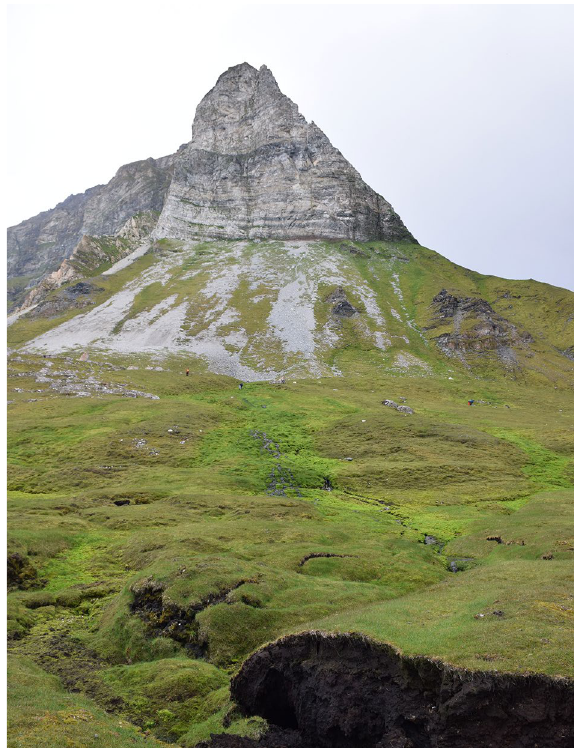
Figure 5. The general view of the Alkhornet study site. Thick peat layer can be seen in the wall of erosion gully on the front and bird cliff providing nutrients for the site in the back of the